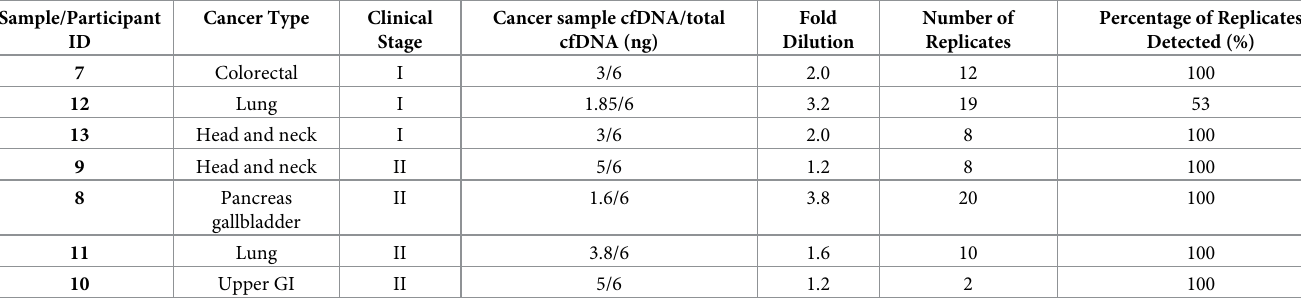
Table 3. In vitro dilution analysis of additional early-stage